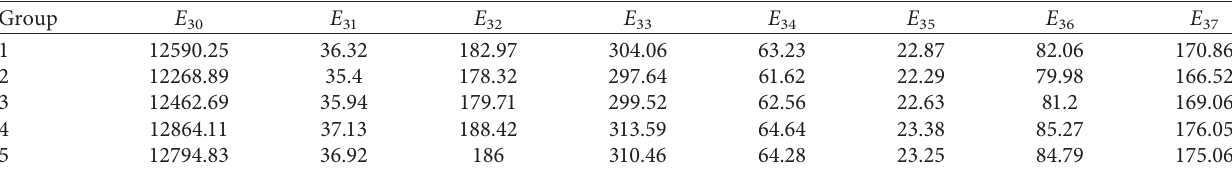
Table 1: The output energy of the signal